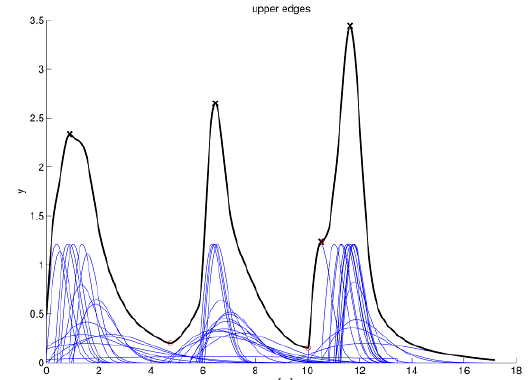
Figure 10. PDFs for all upper edges (blue) shown in Figure 9 and the combined function (black) with the final edge positions (black x).